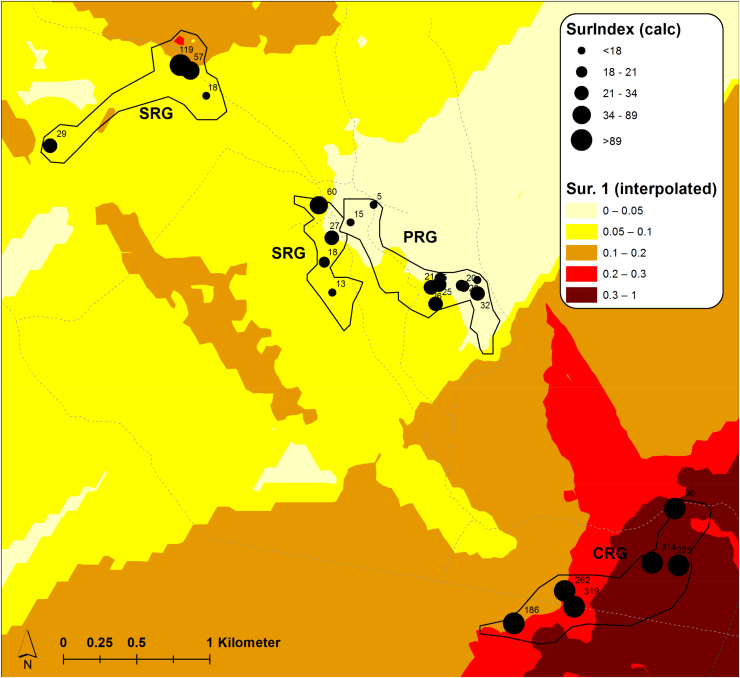
Surrounding CBSD values for PRG, SRG and CRG fields of Mkuranga, eastern coastal Tanzania, plotted over an interpolated spatial plot of Sur 1.